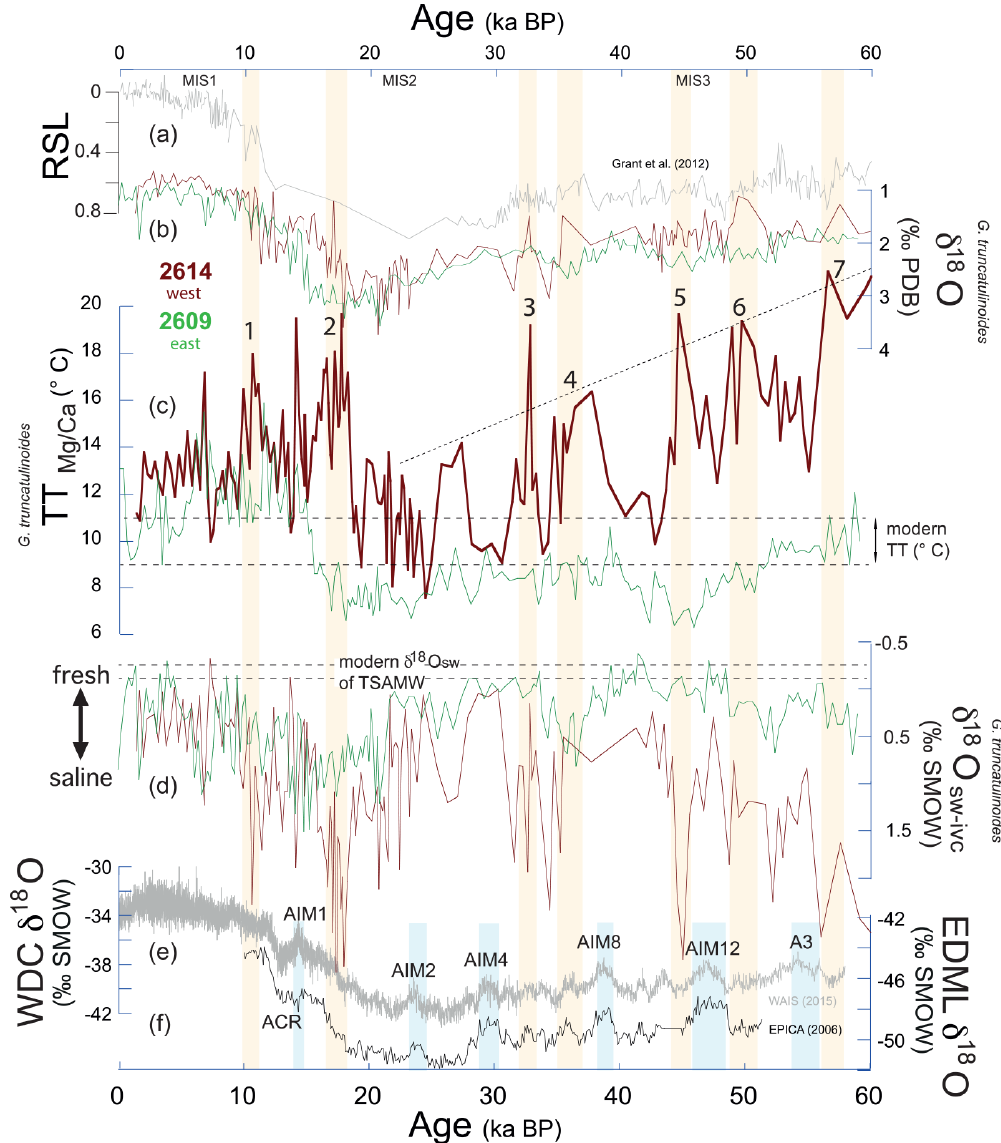
Figure 5. Hydrographic development at thermocline depth over the last 60kyr. Colored curves represent this study, while grey and black curves represent reference records. (a) Relative sea level curve of Grant et al. (2012) (in ‰). (b) Thermocline δ 18 O G. truncatulinoides records at the western (brown; core 2614) and the eastern (green; core 2609) core locations. (c) TT Mg / Ca records derived from G. truncatulinoides (brown: core 2614; green: core 2609). (d) Thermocline salinity approximations ( δ 18 O sw-ivc ) at the western (brown) and eastern (green) core locations. (e) West Antarctic Ice Sheet Divide Core (grey; WAIS Divide Project Members, 2015) and (f) EDML (black; EPICA Community Members, 2006) δ 18 O records as reference for the Southern Hemisphere climate signal. Blue shading shows the Antarctic Isotope Maxima (AIM). Red shading shows the prominent thermocline warming pulses and changes to high salinities at thermocline depth (black numbers). Dashed lines are the modern annual TT range at 50–100m water depth (Locarnini et al., 2019) and modern δ 18 O sw range of TSAMW (Richardson et al., 2019). MIS stands for Marine Isotope Stages 1–3 (Martinson et al., 1987). ACR stands for Antarctic Cold